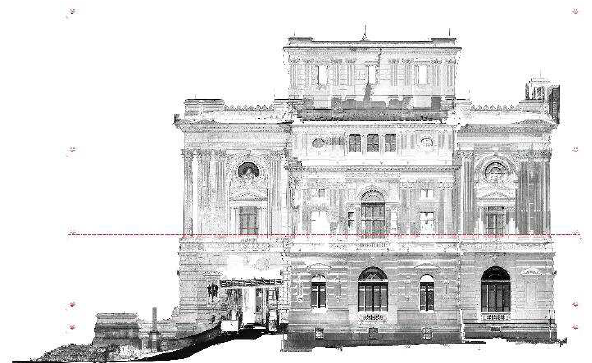
Figure 4. Cross-section and façade with specification of the cutplanes for the identification of the planimetric DEM and analysis of the elevation profile in the relationship between museum and the gardens